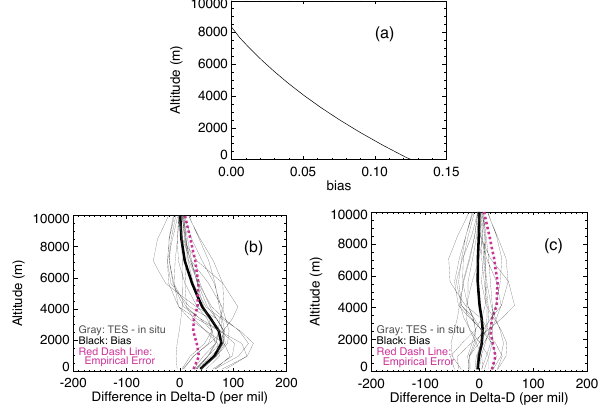
Figure 4. (a) TES V005 HDO / H 2 O bias relative to in situ mea- surements: this is negative δ bias from Eq. (3). (b) Uncorrected com- parisons of TES δ D minus aircraft δ D with averaging kernel applied for the 16 scans that have good quality, DOFS>1.1, and spatially overlap the aircraft flight path (see Table 1). Also plotted are the TES bias (thick black line) and standard deviation (dashed red line). (c) Bias-corrected comparisons of TES δ D minus aircraft δ D with averaging kernel applied for the same scans as in Fig. 4b. In Fig. 4c, TES HDO / H 2 O has been corrected by δ bias (Eq. 3). Also plotted are the TES bias (thick black line) and standard deviation (dashed red